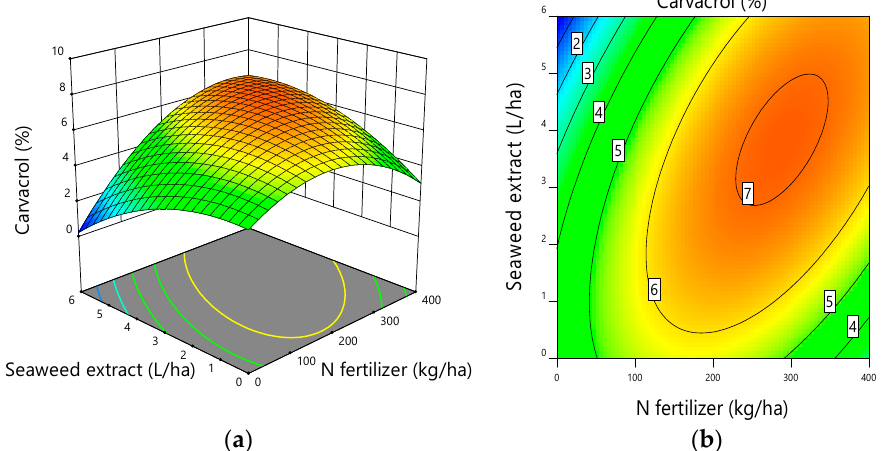
Figure 8. Response surface ( a ), and contour plot ( b ) showing the effect of N fertilizer and seaweed extract on the carvacrol content. The K fertilizer was kept constant at 6 kg ha − 1 .